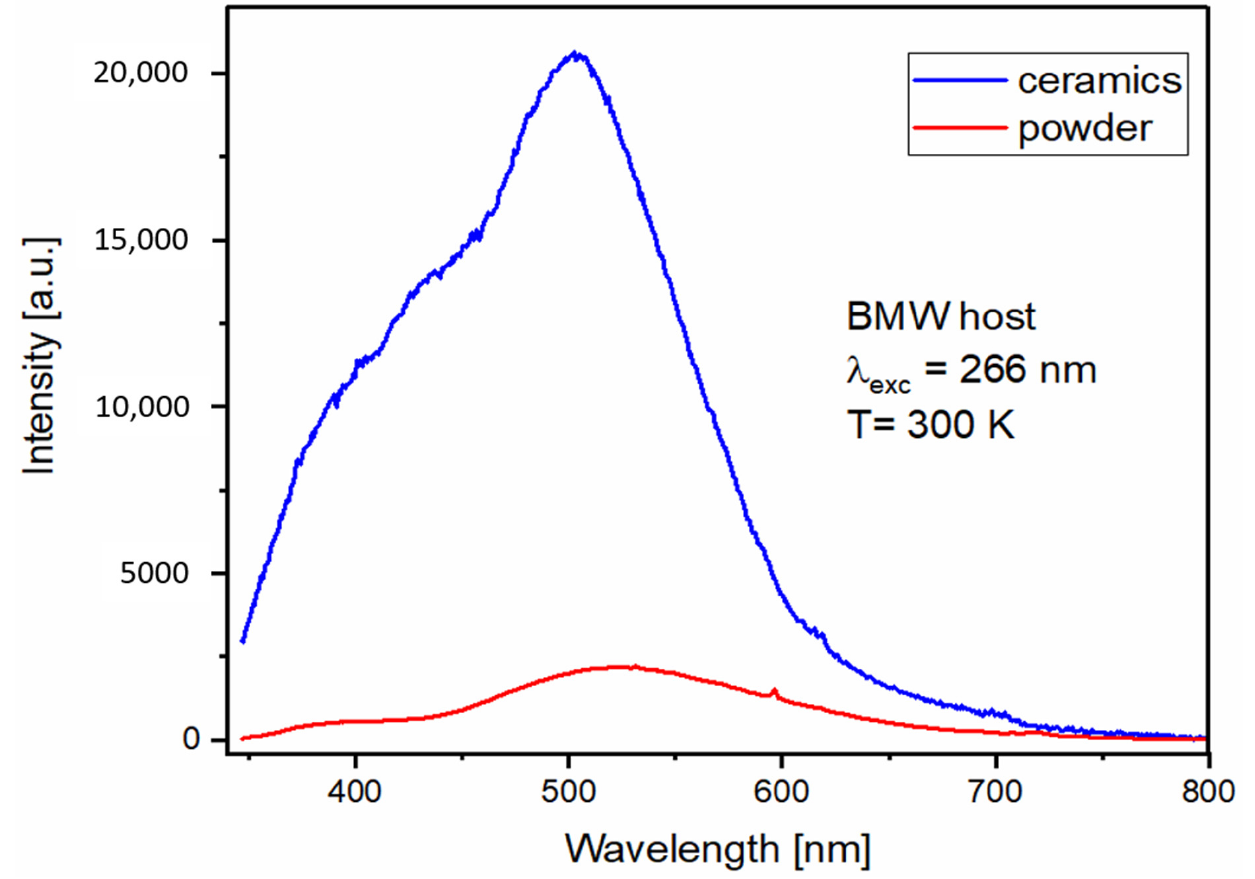
Figure 7. 300 K emission spectra of BMW host powder and ceramic under 266 nm excitation.